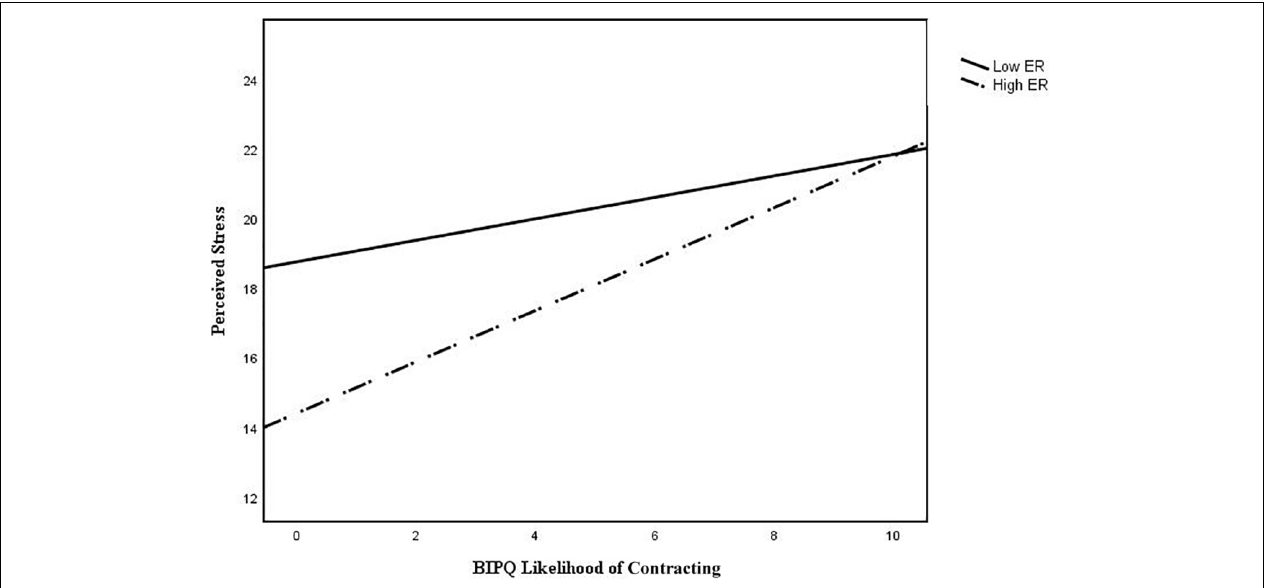
FIGURE 2 | Interaction plot of BIPQ likelihood of contracting and perceived stress with external religious (ER) expression as a moderator.